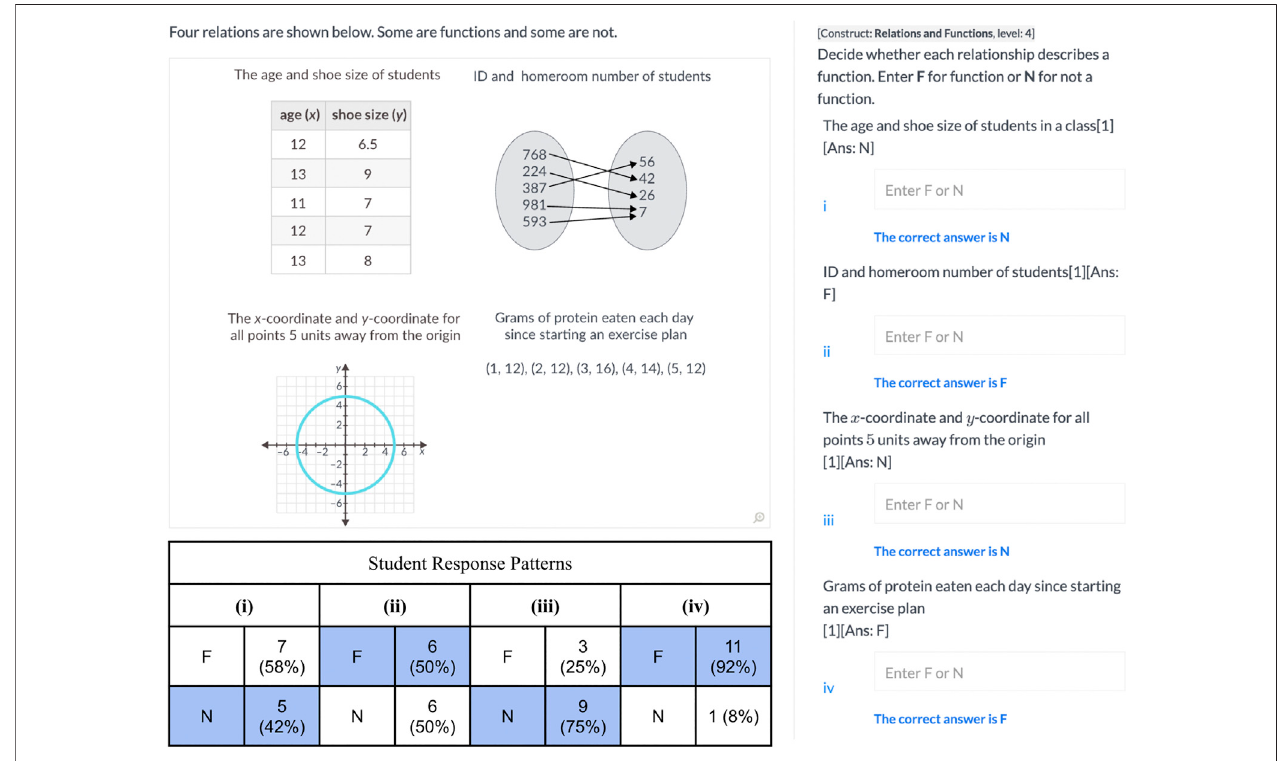
FIGURE 7 | Item 1,270 aligned to Level 4 “ De fi nes a function as a relation which is one to one or many-to-1, but not 1-to-many or many-to-many, and applies the de fi nition to discrete relations, verbal descriptions of two-variable relations, or graphs ”